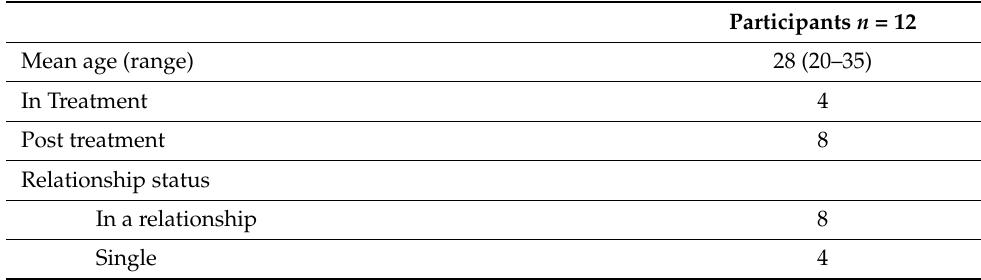
Table 2. Demographic